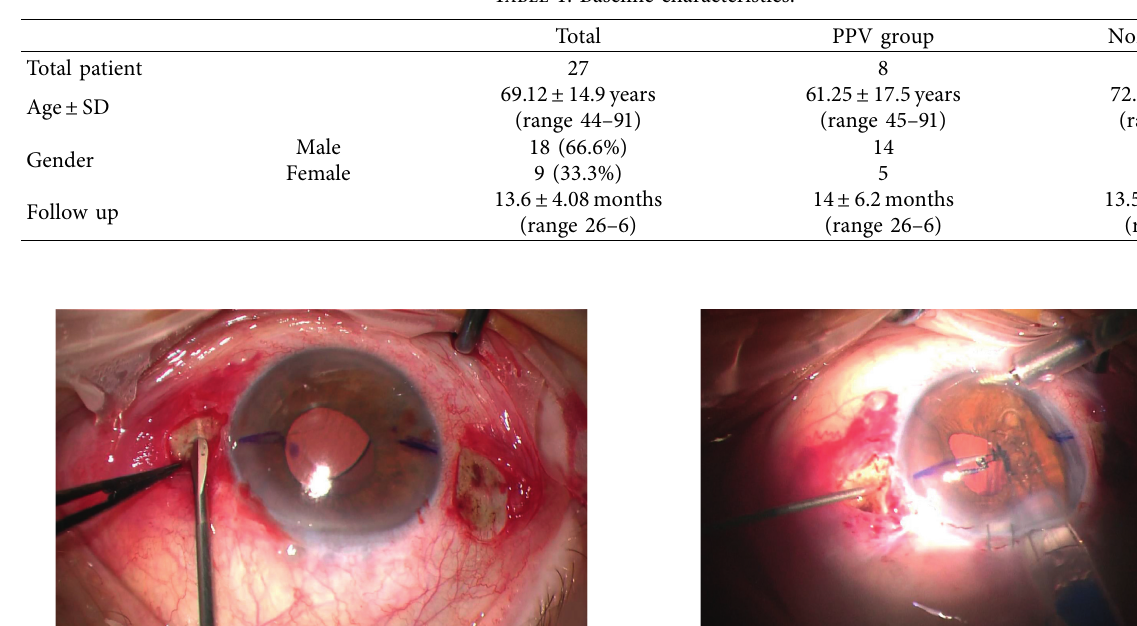
Table 1: Baseline characteristics.